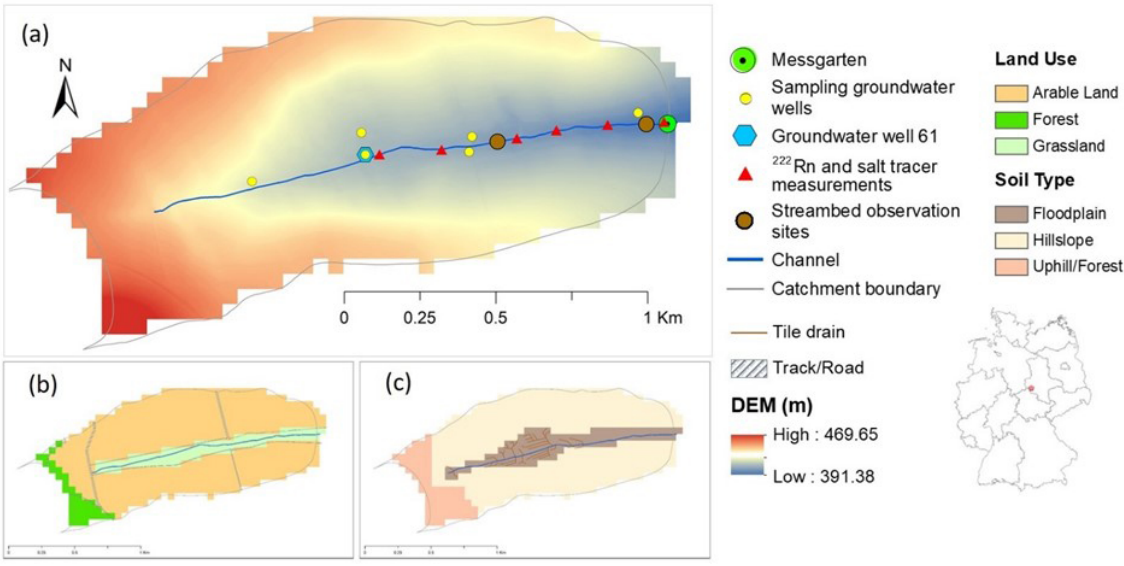
Figure 1. The Schäfertal catchment and monitoring locations used by Yang et al. (2021), showing (a) digital elevation model (DEM) and monitoring sites with sampled groundwater wells, (b) land use types, and (c) soil types and the tile drain network. A V-notch weir is installed in the “Messgarten” climate station for discharge measuring and stream water sampling (adapted from Yang et al.,